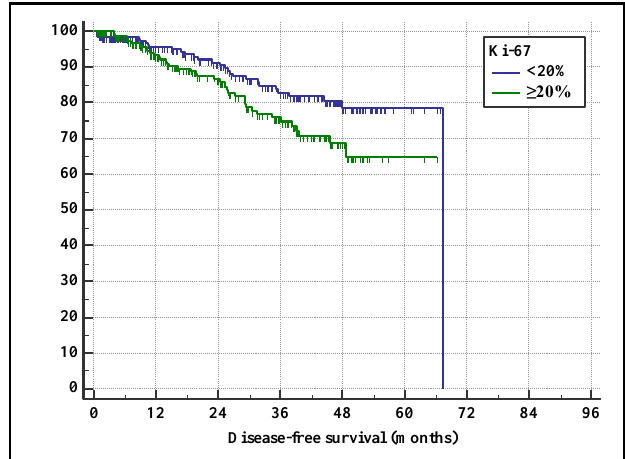
Figure 3: Kaplan-Meier disease-free survival estimates according to Ki-67 cutoff value of 20%